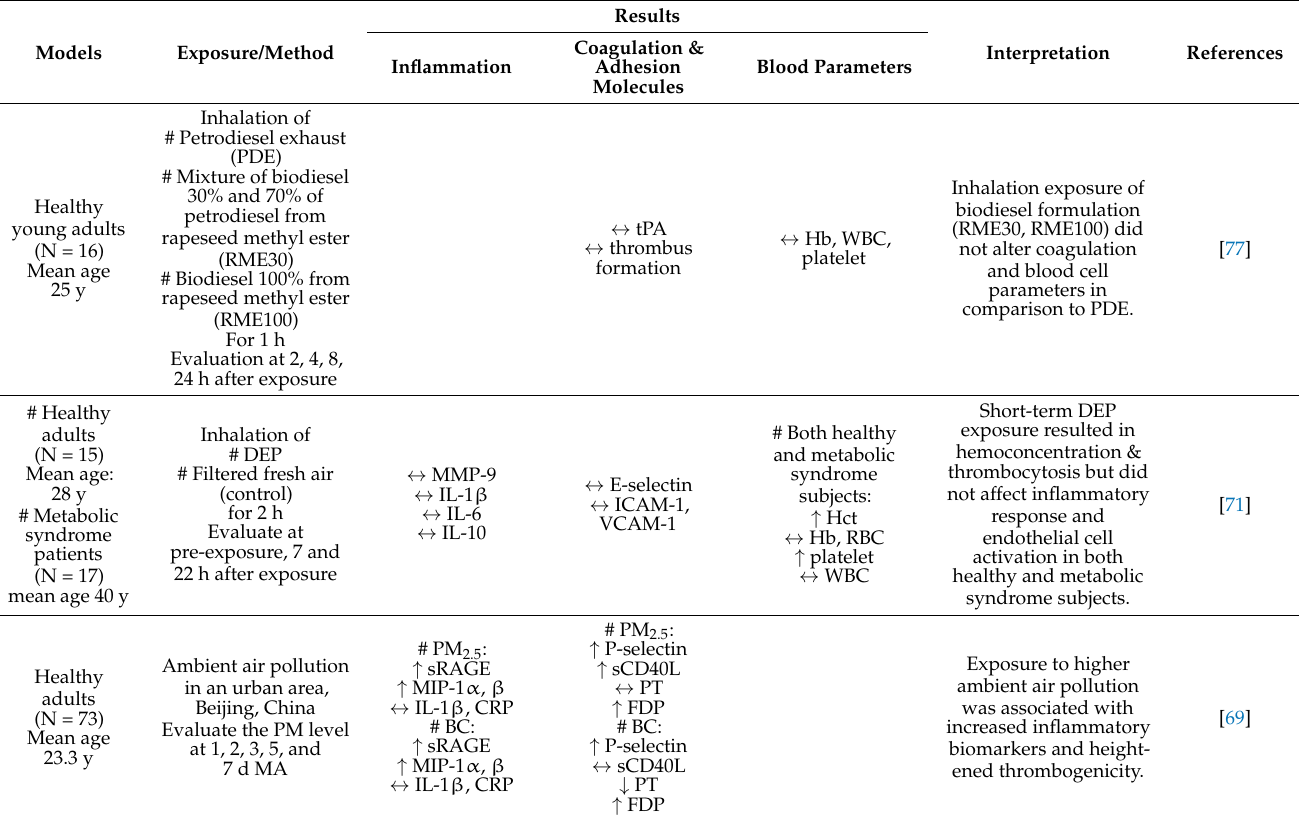
Table 4. The effects of particulate matter on inflammation, oxidative stress, adhesion molecules, and thrombosis: Evidence from clinical